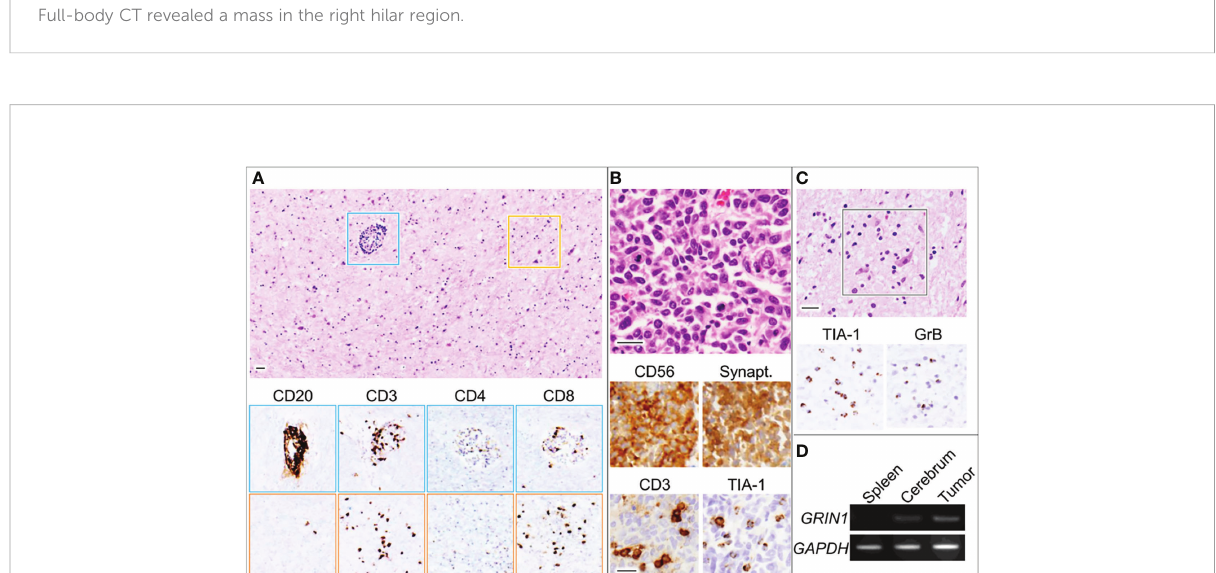
FIGURE 2 Full-body CT revealed a mass in the right hilar